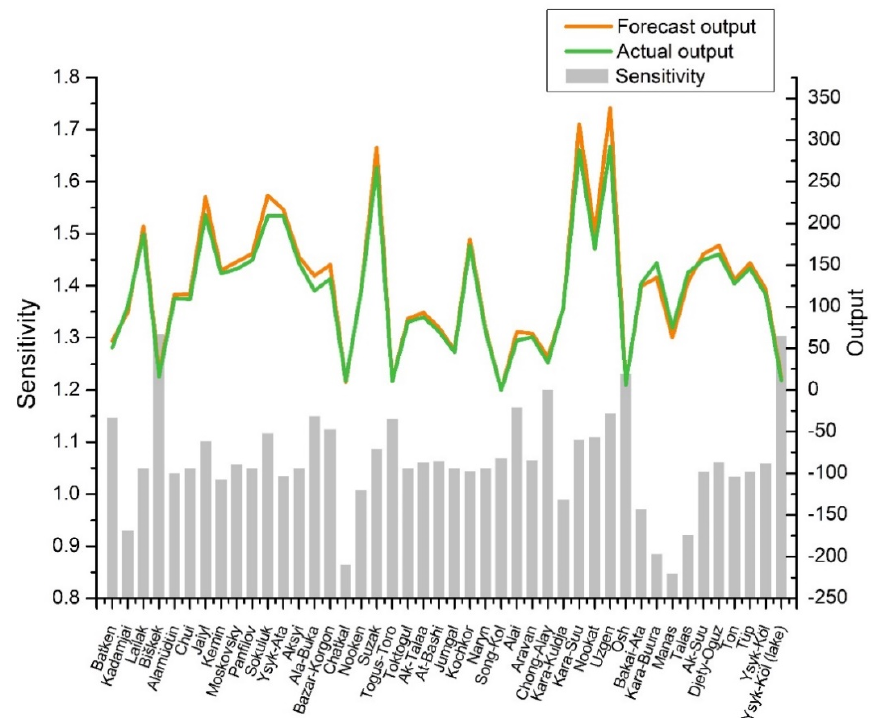
Figure 2. Expected crop yield, actual yield and sensitivity of various regions.